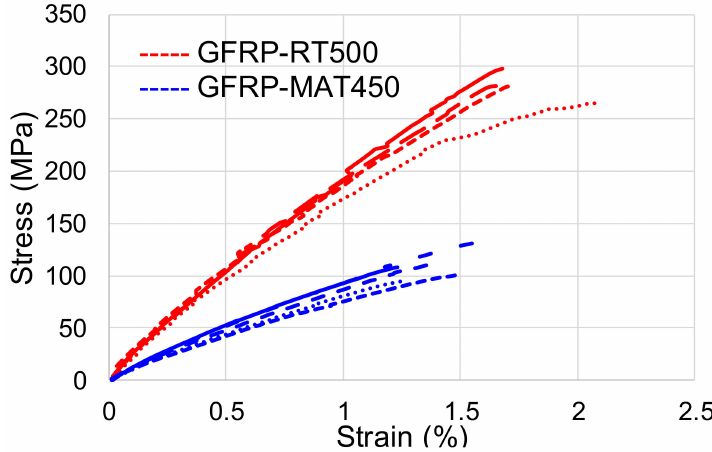
Figure 2. Superimposed stress–strain curves obtained during tensile